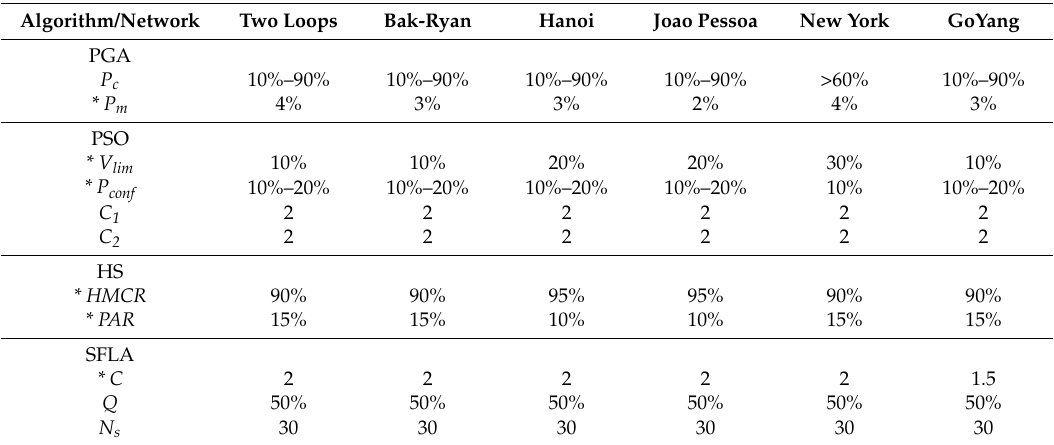
Table 1. Optimal specific parameter calibration for the considered networks.